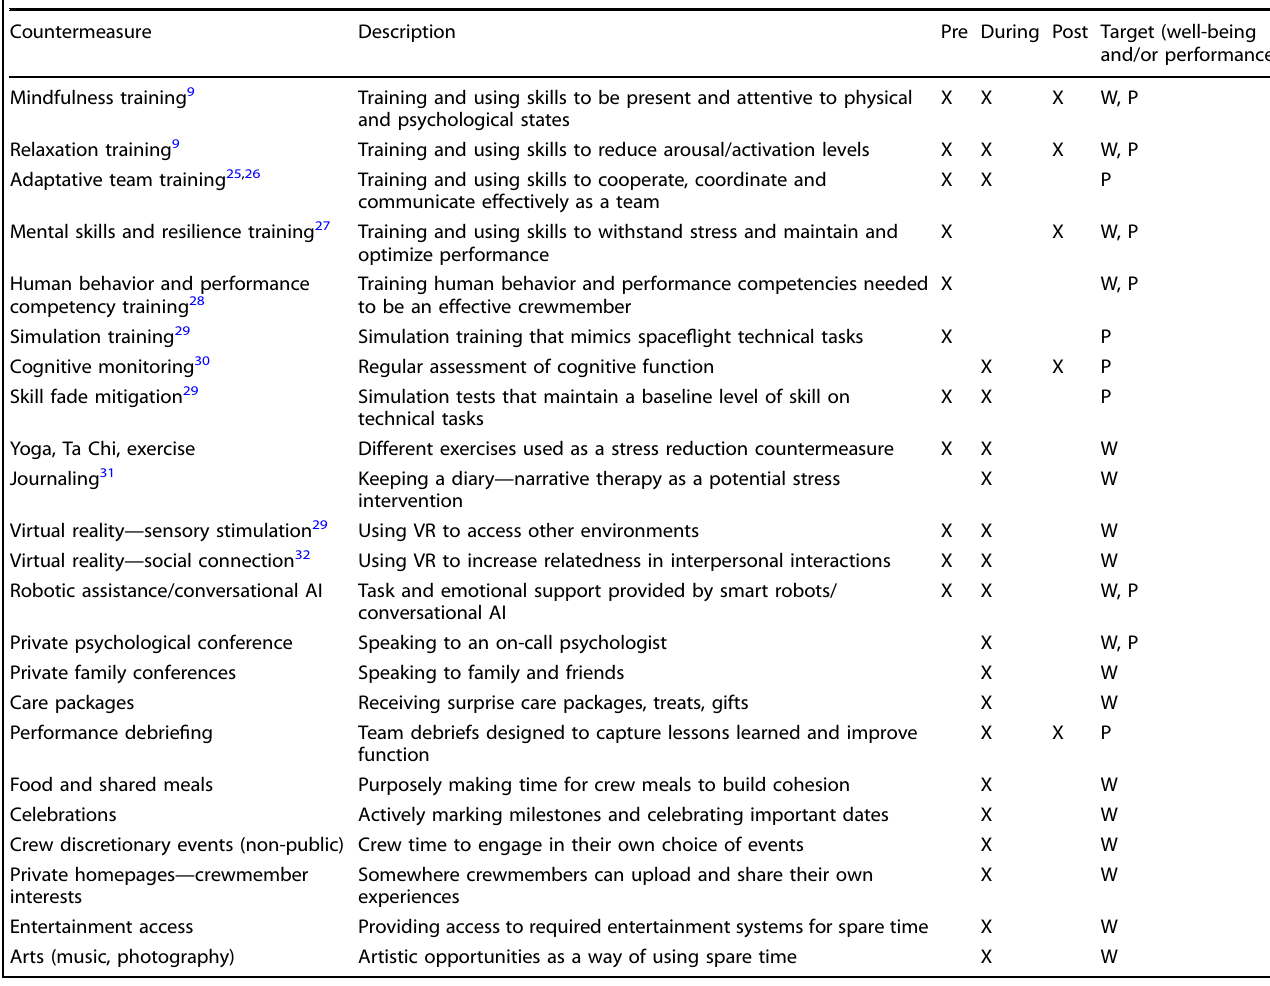
Table 2. Available and to be developed